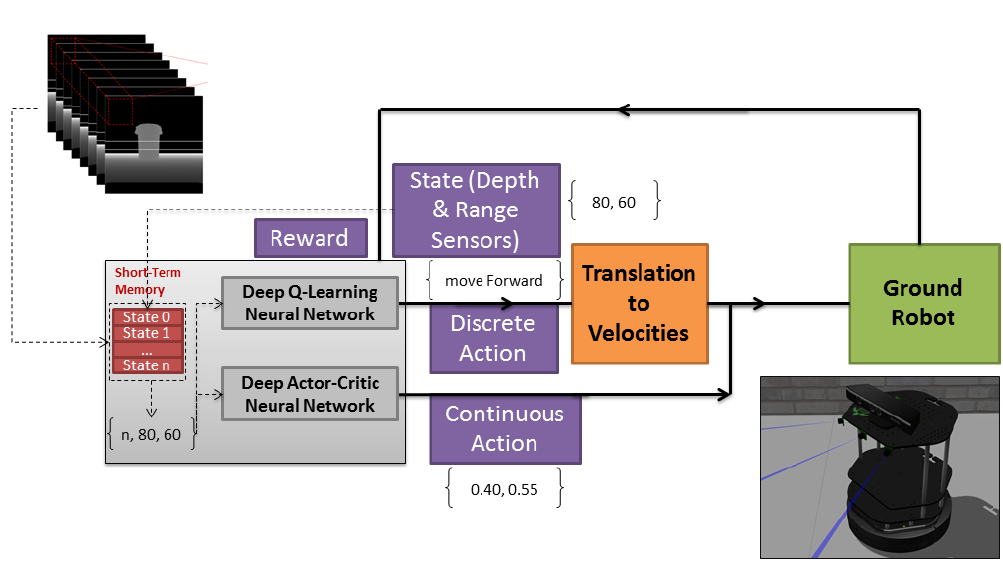
Figure 1. MDRL algorithm work